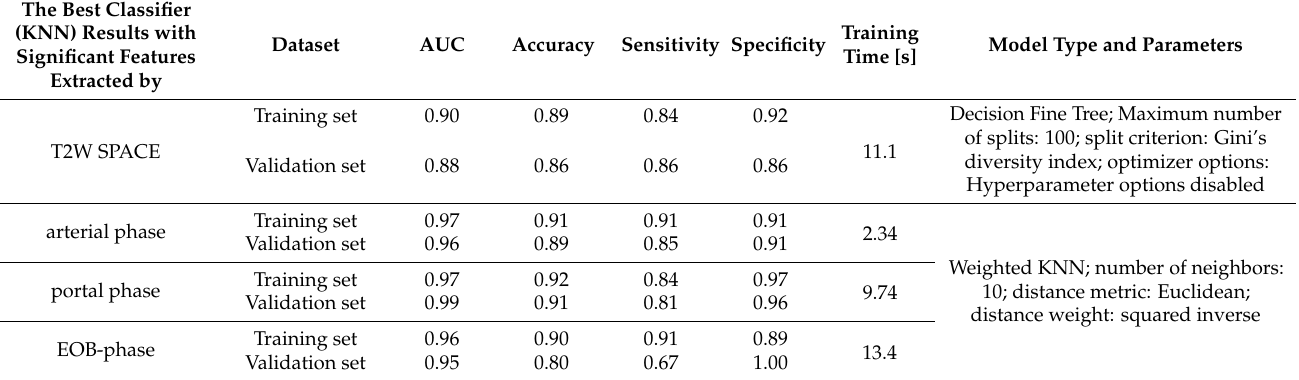
Table 6. Pattern recognition analysis with significant features.